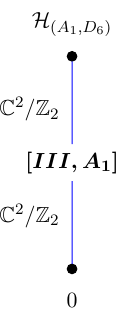
Figure 13. The Hasse diagram for the Higgs branch of the ( A 1 ; D 6 ) AD theory. Following the convention of [30] we blue for Hasse diagrams of Higgs